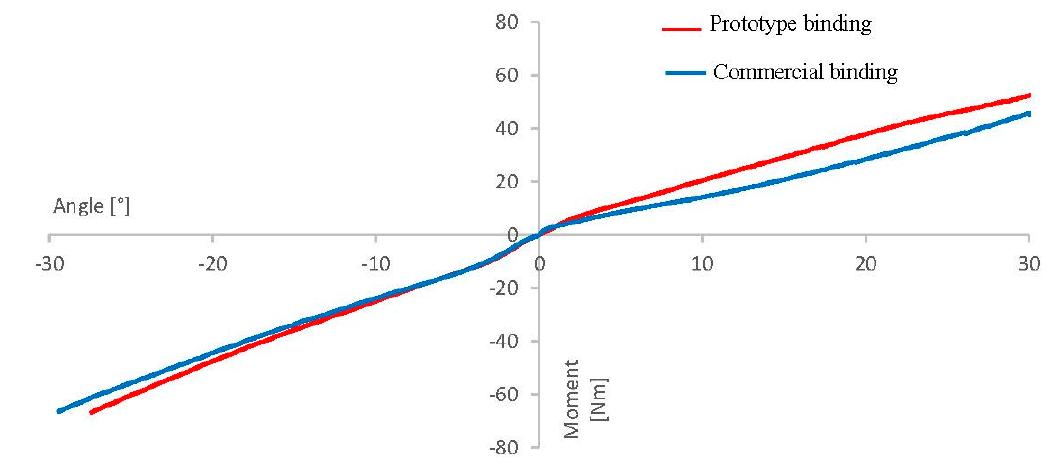
Figure 8. Comparison of the flexural behavior of the prototype and of the commercial binding.